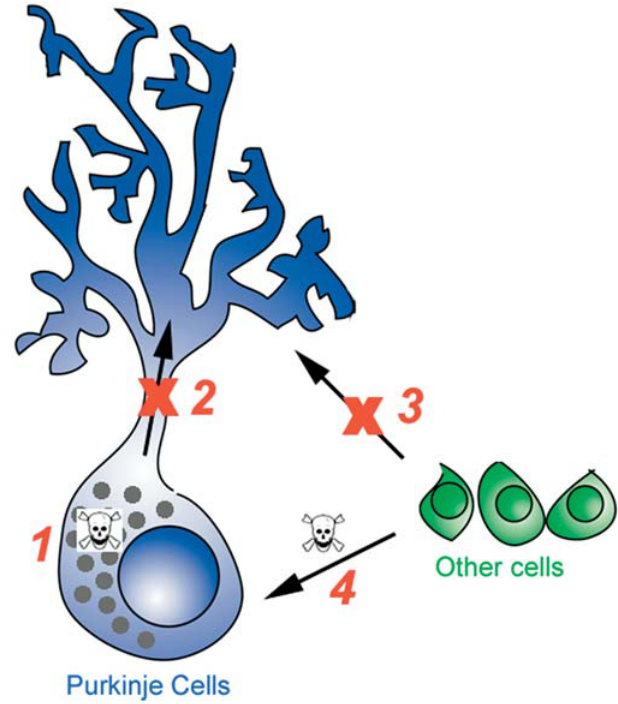
Figure 1. Models of PC Degeneration in npc1 Mice Four basic mechanisms are depicted. (1) The accumulation of cholesterol, sphingolipids, or other molecules within PCs lacking Npc1 could be toxic. (2) Loss of Npc1 function could cause a block in trafficking that leads to a localized subcellular deficiency in lipids and/or proteins. (3) Other cells, most likely glia, could produce a secreted factor, such as apoE- cholesterol or a trophic factor required for PC survival, whose export is reduced or blocked without Npc1 function. (4) Any cell type in the npc1 mouse could produce toxic metabolites, such as released lysosomal hydrolases or beta amyloid, that could kill surrounding cells or particularly susceptible cell types regardless of genotype. DOI: